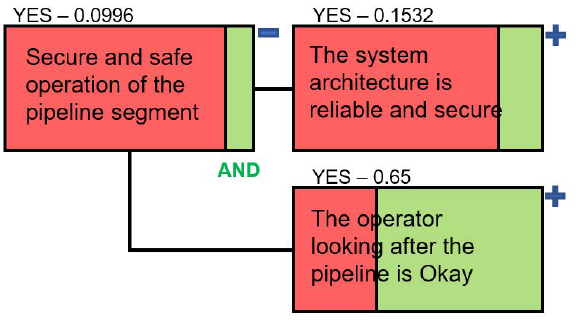
Figure 5. Top-Level DM Configured for the Water Distribution